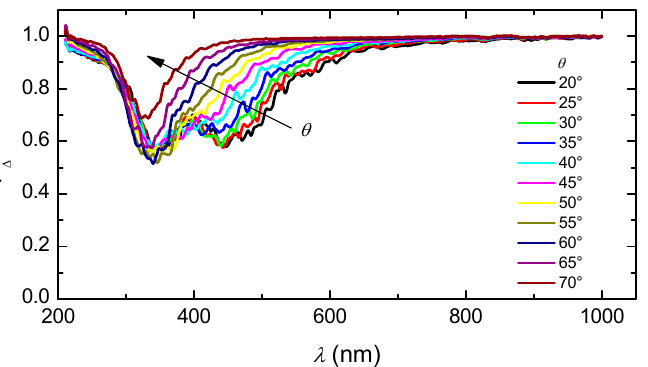
Figure A3. Polarization index of Mueller matrices at several angles of incidence in Figure A1.